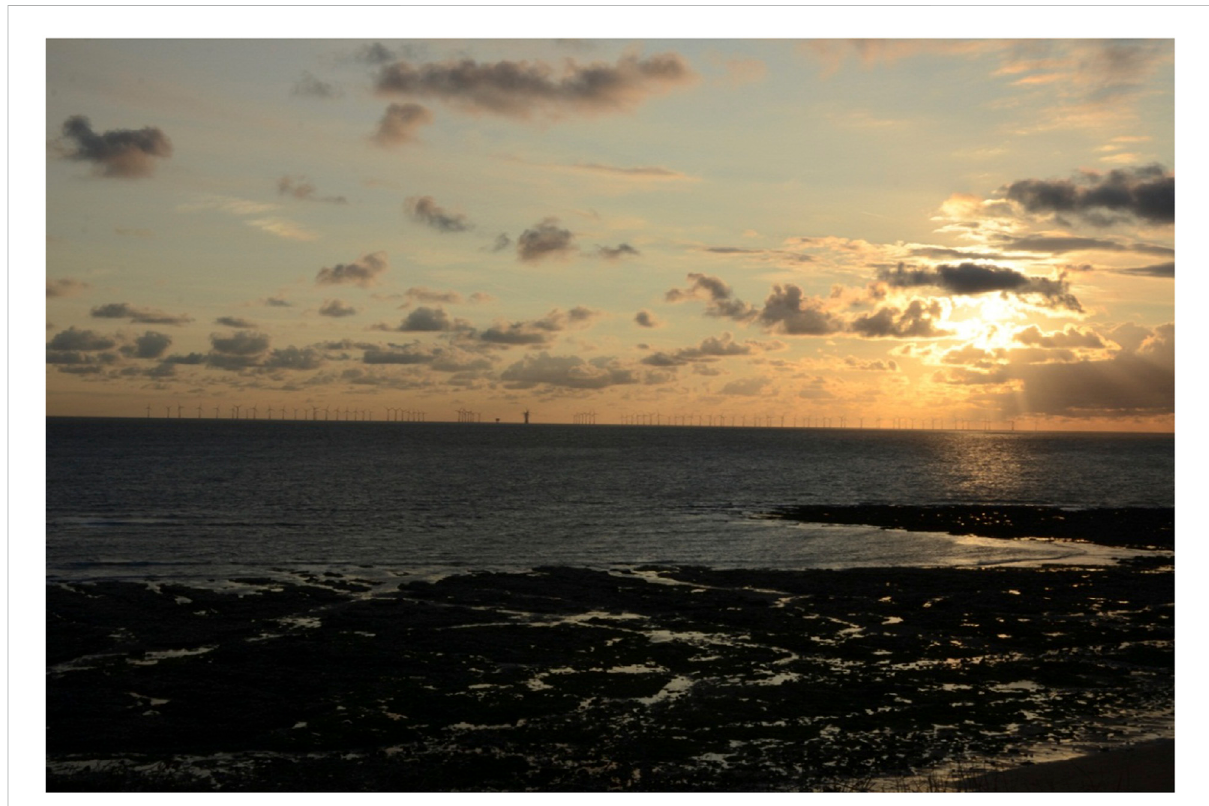
FIGURE 2 Asampleoflowvisualimpactwithlackofexpressivenessofchanges.Insuchasituation,theinfrastructuresarenotfarenoughawaytoeliminate their visibility on the horizon and not close enough to be perceived from the coast. Source of image: Sullivan et al., 2012b, page 6 of the conference